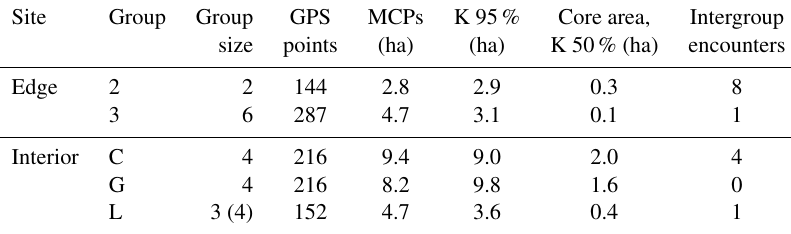
Table 3. Results of the home range estimates of each group based on different methods.